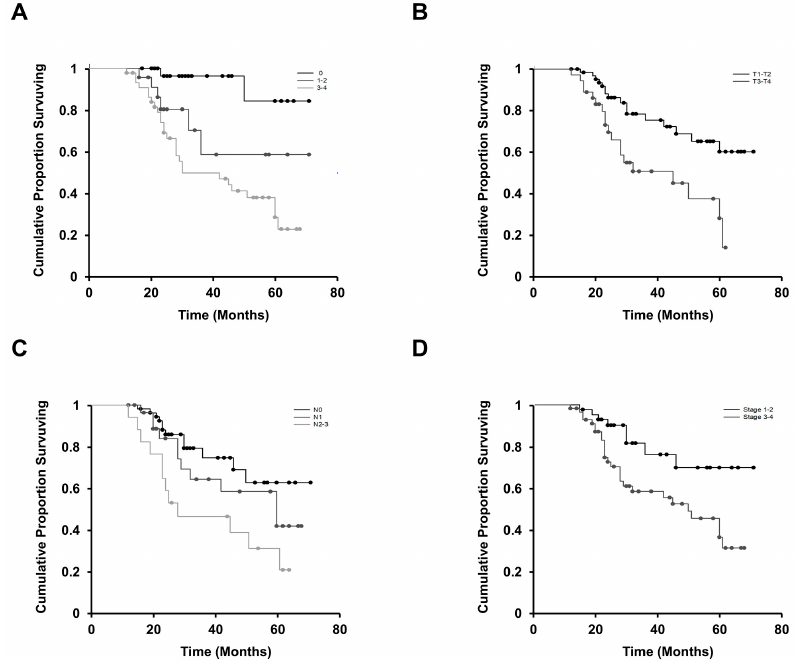
Figure 2. Kaplan–Meier survival curves of 100 patients with OSCC. ( A ) The cumulative survival for patients with none or a low degree (0–2) of LIF staining was significantly higher than that for patients with a high degree (3–4). ( B ) Overall survival was significantly lower in patients with a larger tumor size (T3 + T4) than in those with smaller tumor size (T1 + T2) ( p = 0.002). ( C ) Overall survival was